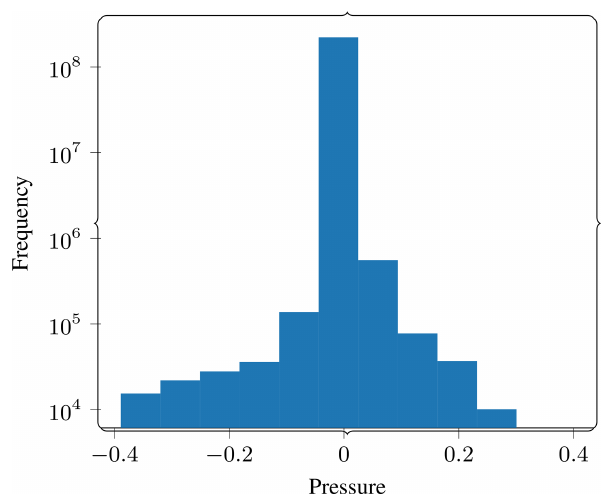
Figure 4. Evolution of compressibility through the simulation. We compressed every time step of the reference problem using an ab- solute error tolerance ( atol ) setting of 10 − 4 . The compression fac- tor achieved is plotted here as a function of the time step number. Higher is more compression. The dotted line represents no com- pression. We can see that the first few time steps are compressible to 1000x since they are mostly zeros. The achievable compression factor drops as the wave propagates through the domain and seems to stabilize to 20x towards the end. We pick the last time step as the reference field for further experiments.